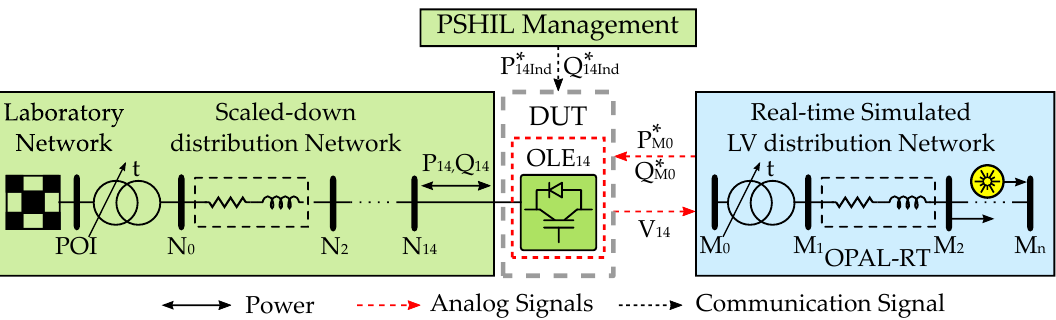
Figure 7. PSHIL application example. One-line diagram of the LV real-time simulated network.